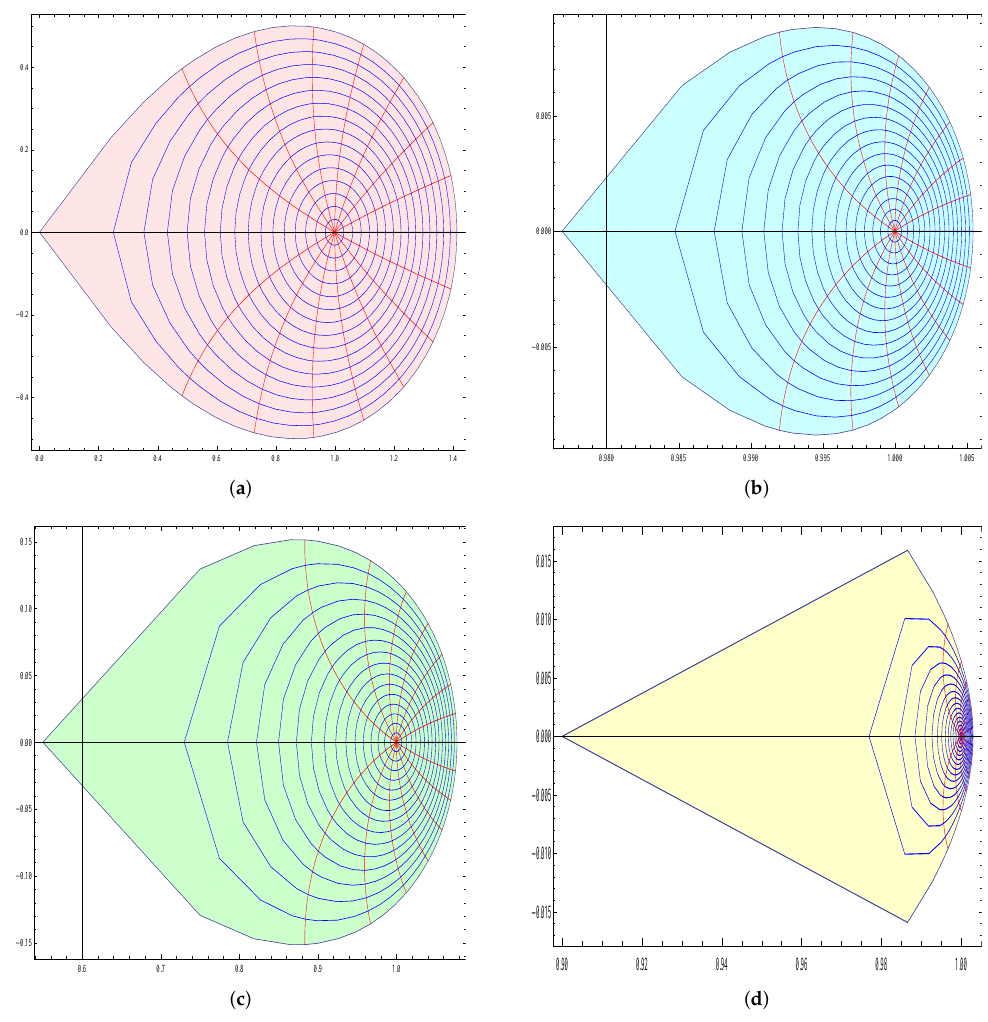
√ 1 + z . ( a ) Mapping of E under the √ 1 + z . √ 1 + z